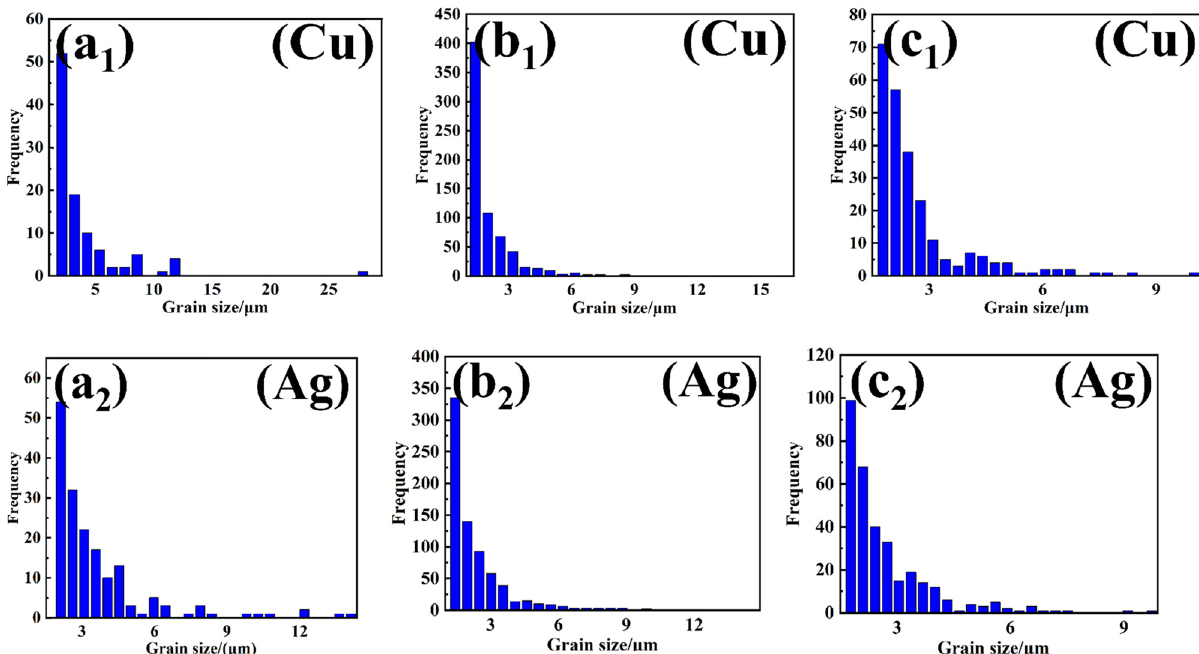
Figure 6: Distribution of the grain sizes of Ag ( s.s ) and Cu ( s.s ) in the brazing seam. ( a 1 ) and ( a 2 ) 0%; ( b 1 ) and ( b 2 ) 2%; ( c 1 ) and ( c 2 ) 3%.